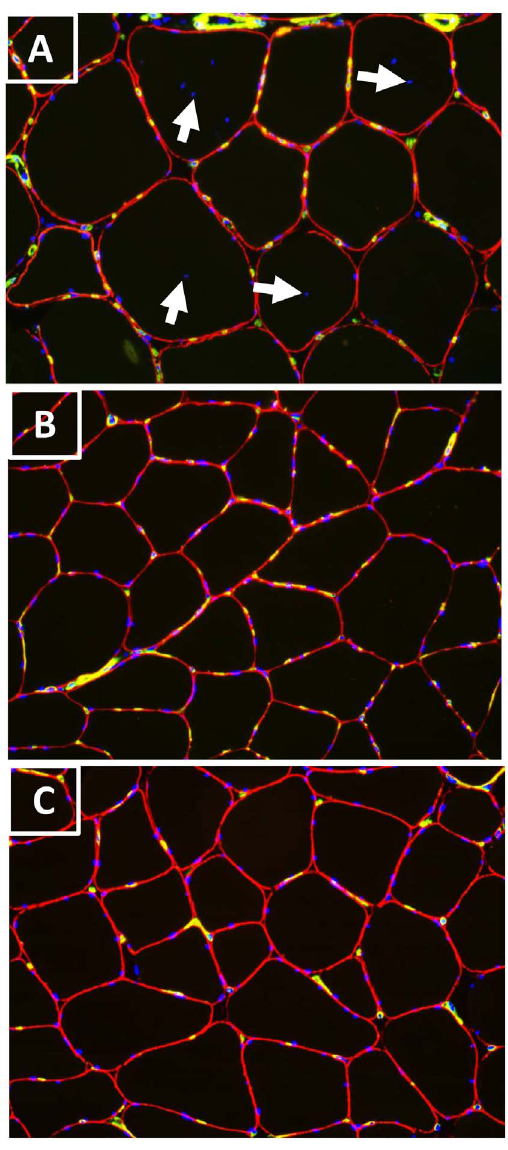
Figure 1. Multiple labeled muscle cross-sections with DAPI (Blue) for nuclei, mAb 4C7 (green) for capillary and mAb 5H2 (red) for fiber membrane. Sections from one Doped athlete using higher (A; . 2500 mg ? week 2 1 ) and one using lower doses AAS (B; , 500 mg ? week 2 1 ), and from one Clean athlete (C). Doped athletes with higher doses AAS showed larger fiber areas (A) than Doped athletes with lower AAS doses (B) and Clean athletes (C). More capillaries and nuclei around each type I fiber were observed in the Doped athletes (A and B) compared to Clean (C). Internal nuclei are marked with arrows in